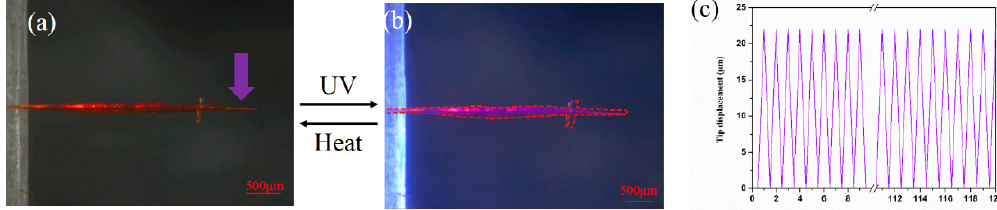
Figure 7. Photomechanical motion of a needle-like complex-I crystal at room temperature: ( a ) before and ( b ) after UV irradiation from the right above on the image (indicated by the purple arrow) and the red dashed line is the original position of crystal. ( c ) Graph shows the repeatability of the reversible bending over as many as 120 cycles.